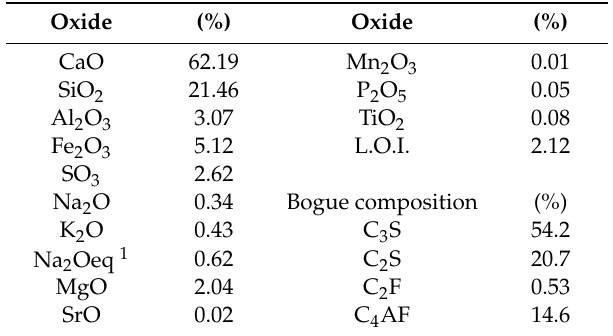
Table 1. Chemical and mineralogical composition of Portland cement used. Oxide